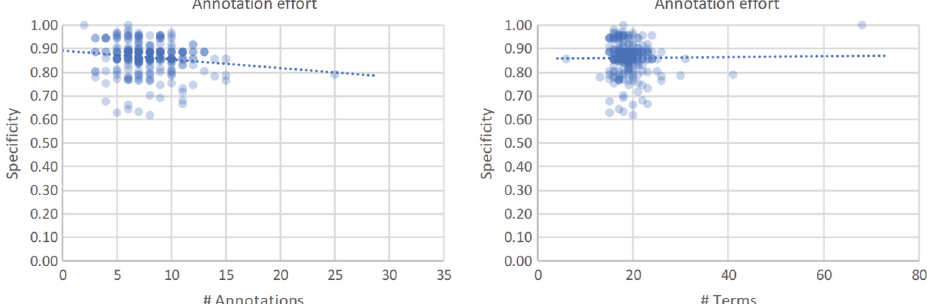
Figure 6: The correlation between specificity of a resource and the number of annotations using ontology concepts (left) or the total number of text terms (right) in that